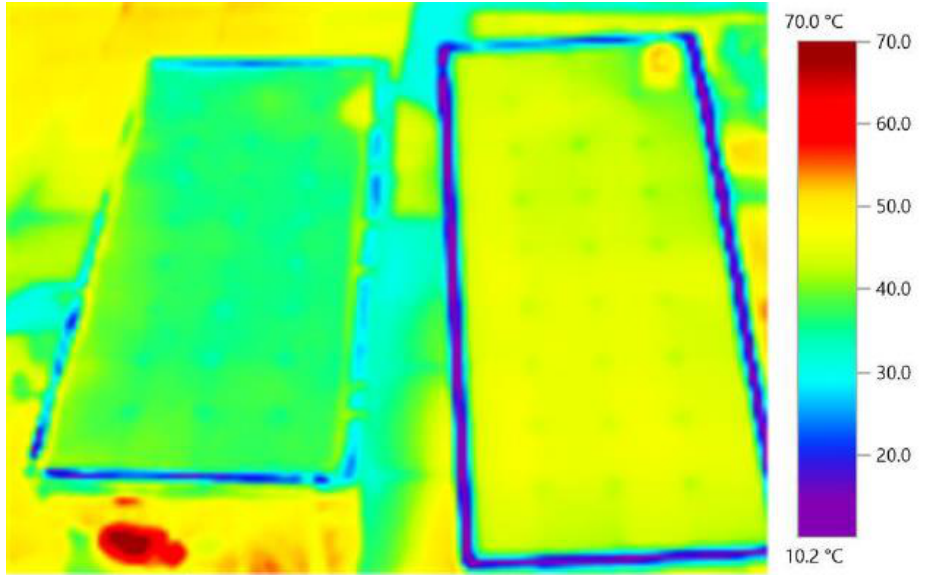
Figure 8. Thermal image for both panels, cooled ( left ) referenced ( right ).